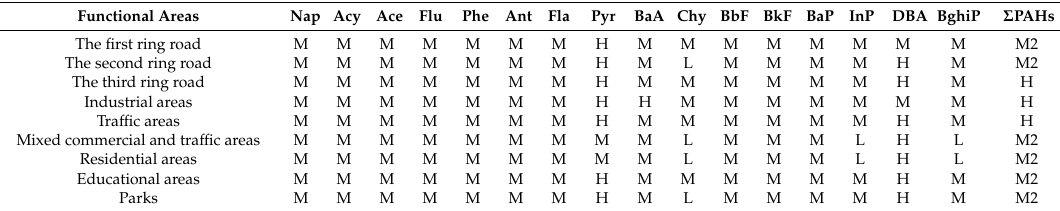
Table 6. Ecological risk of individual and total PAHs in the urban soil in urban functional areas in Xi’an. Functional